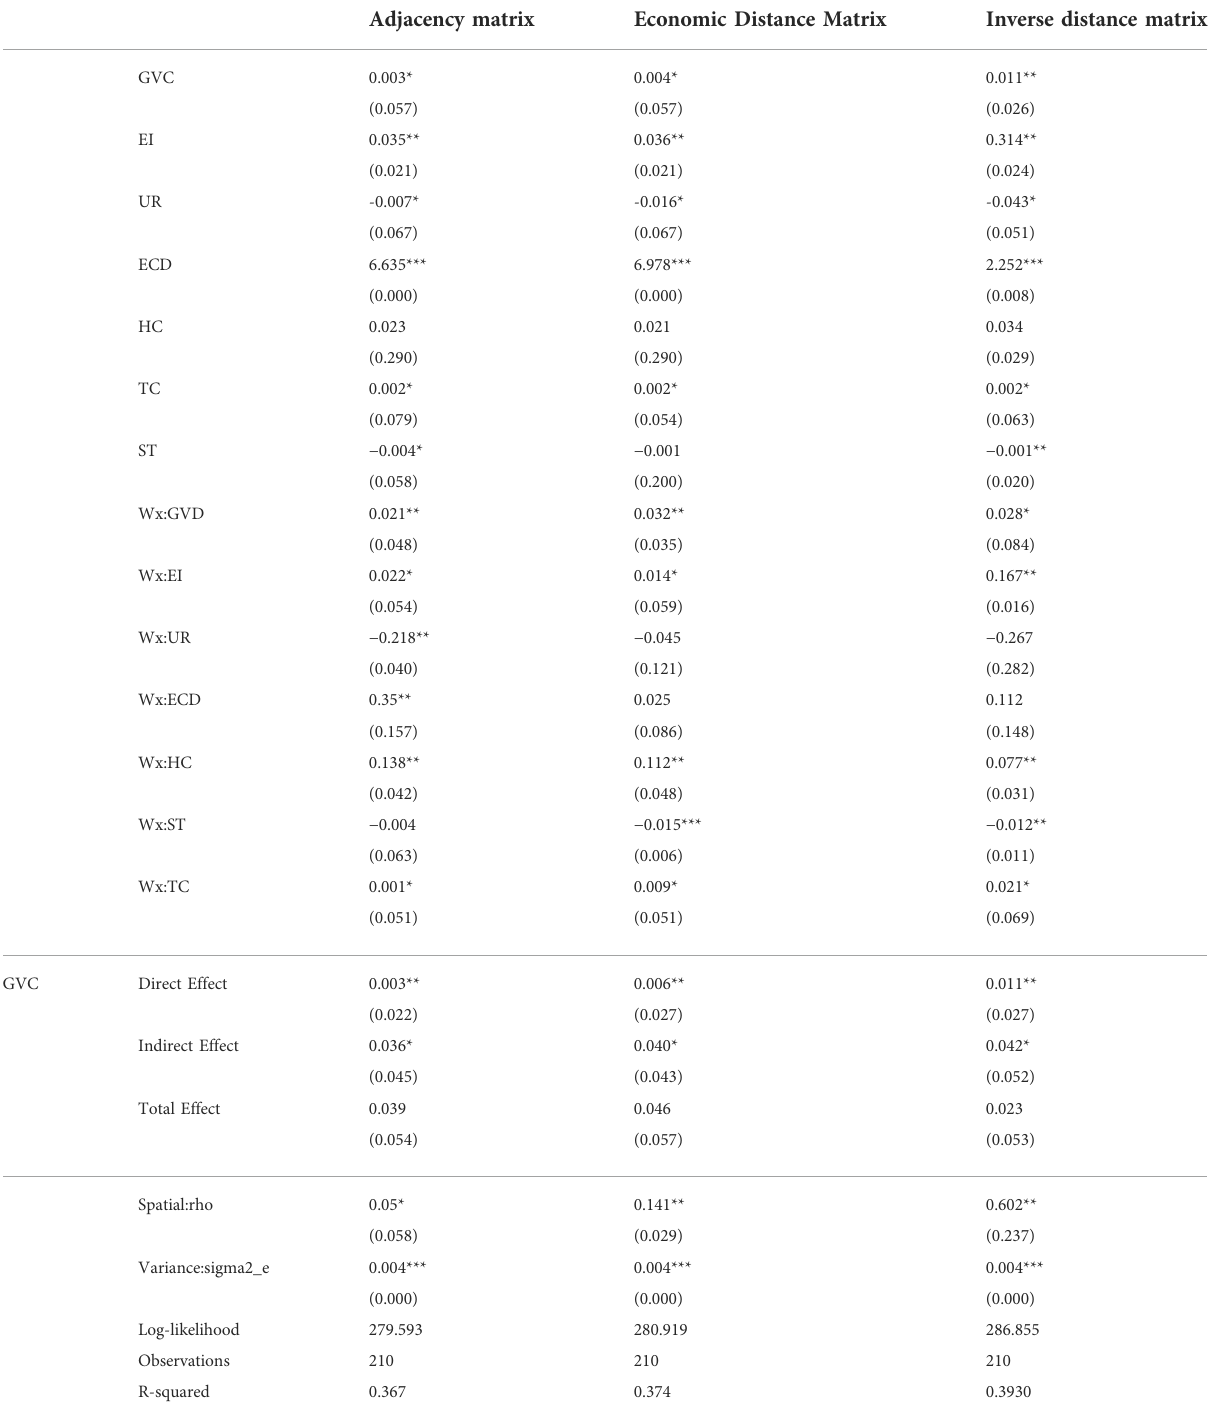
TABLE 4 Estimation results of Model